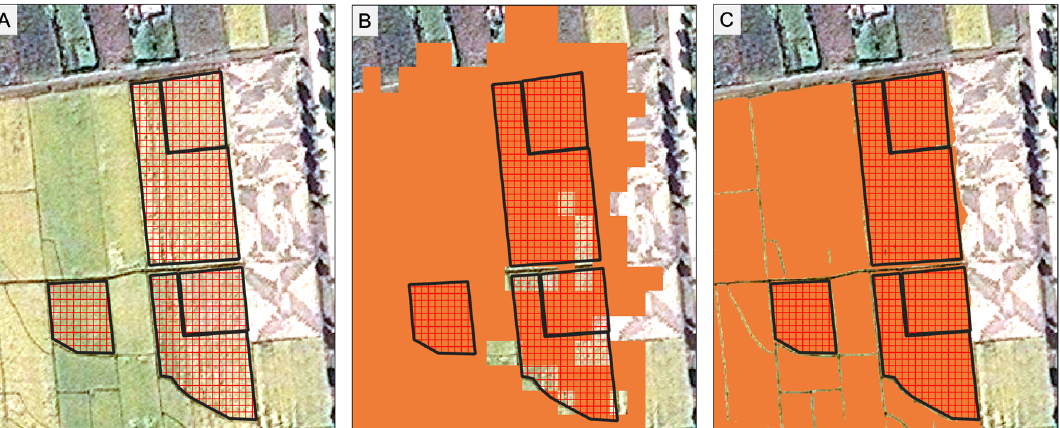
Figure 10. Evaluation by the test set for rice field mapping: ( A ) sample rice fields in test set, ( B ) sample rice fields overlay with pixel-wise classification by decision-tree classifier, and ( C ) sample rice fields overlay with rice field map produced by the proposed method.